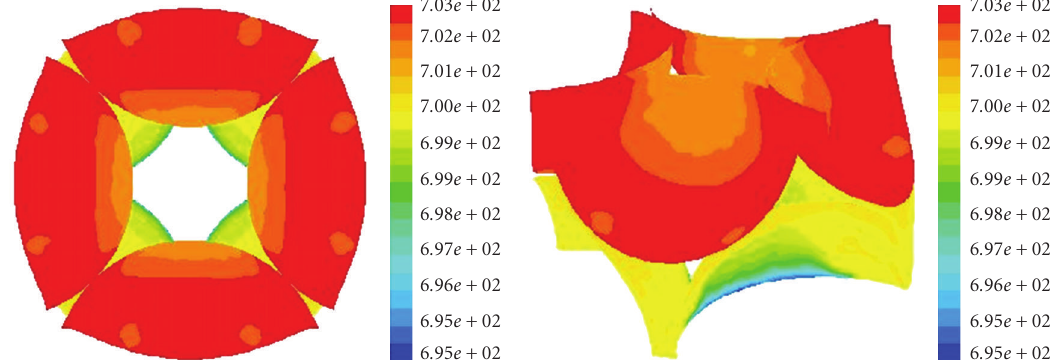
Figure 15: Two views of the wall temperature distribution (in Kelvin degrees) for FCC cell “trs1” (LOFA—Average Channel).